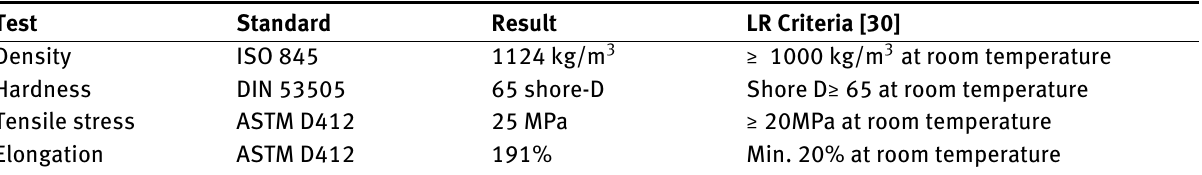
Table 1: Mechanical properties of the polyurethane elastomer and the requirements of the core material in Lloyd’s Register standard [30]